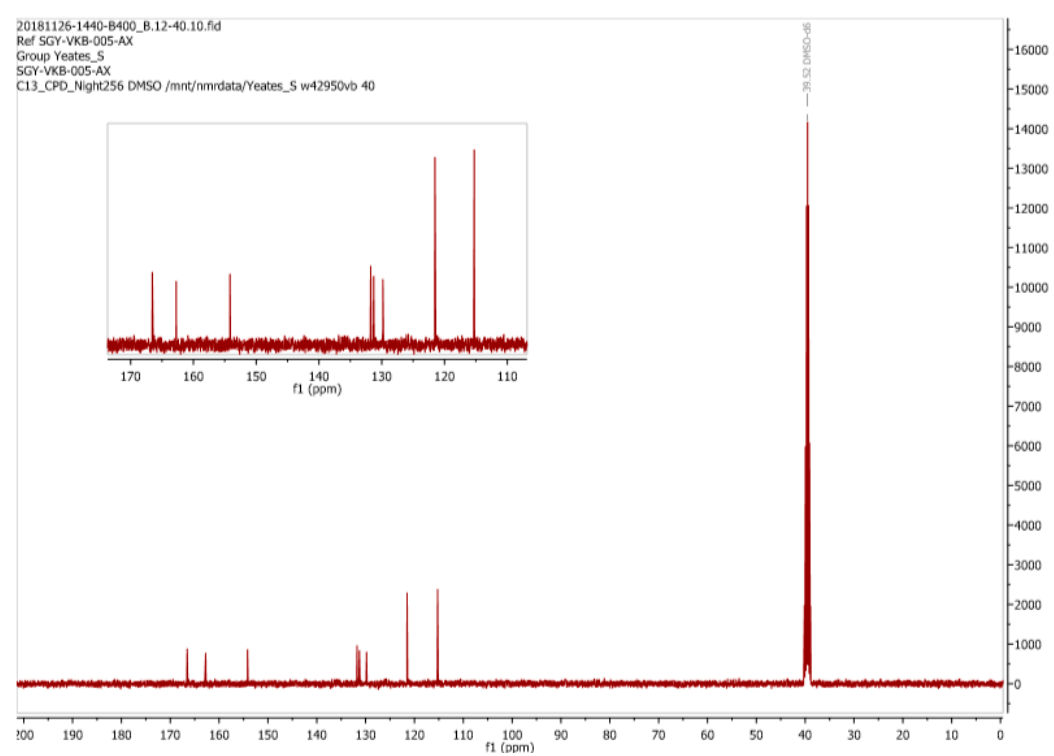
Figure 10. 13 C-NMR spectrum of an authentic sample of ( 3 ) in DMSO- d 6 prepared in this study.